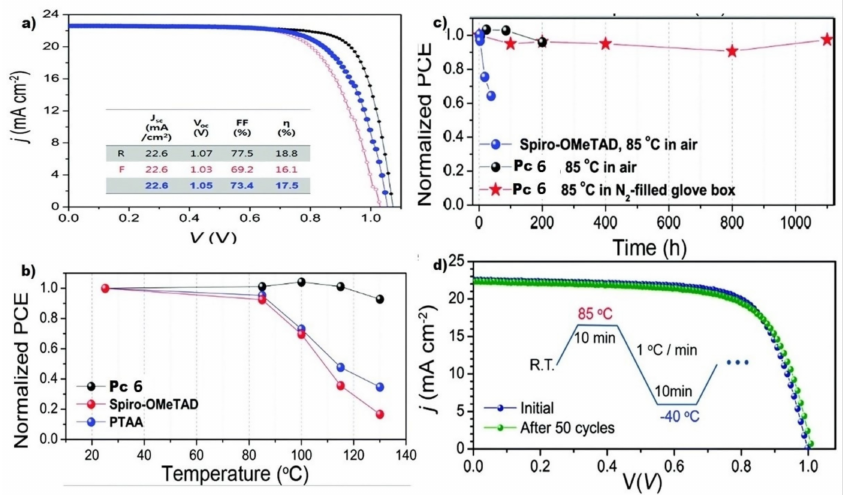
Figure 6. Cell performance and thermal stability. ( a ) J–V curves for the best cell using Pc 6 as HTM (in reverse (black) and forward (red) scans). The photovoltaic parameters of the best cell are shown in the inset table (average values in blue); ( b ) Stability of the devices tested at different temperatures (25, 85, 100, 115, and 130 ◦ C, respectively) for 30 min, employing Pc 6 (black color), spiro-OMeTAD (red color), and PTAA (blue color); ( c ) Long-term stability of the devices stressed at 85 ◦ C in air (25–30% humidity), using Pc 7 (black color) and spiro-OMeTAD (blue color) and 1100 h stability of the device utilizing Pc 6 at 85 ◦ C in a nitrogen-filled glove box (red color); ( d ) J–V curves of a Pc 6 device before and after the thermal cycling test of 50 cycles within the temperature range between − 40 ◦ C and 85 ◦ C. Adapted with permission from ref [92]. Copyright 2018 The Royal Society of